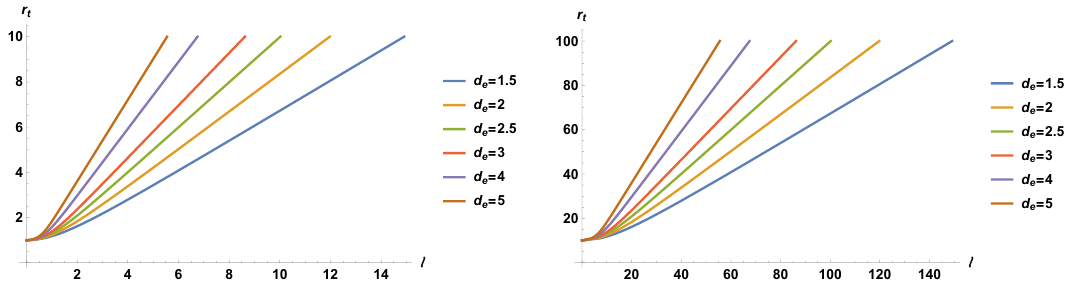
Figure 2 . r t as a function of ‘ for different values of the cutoff: Left ) r c = 1 Right ) r c = 10